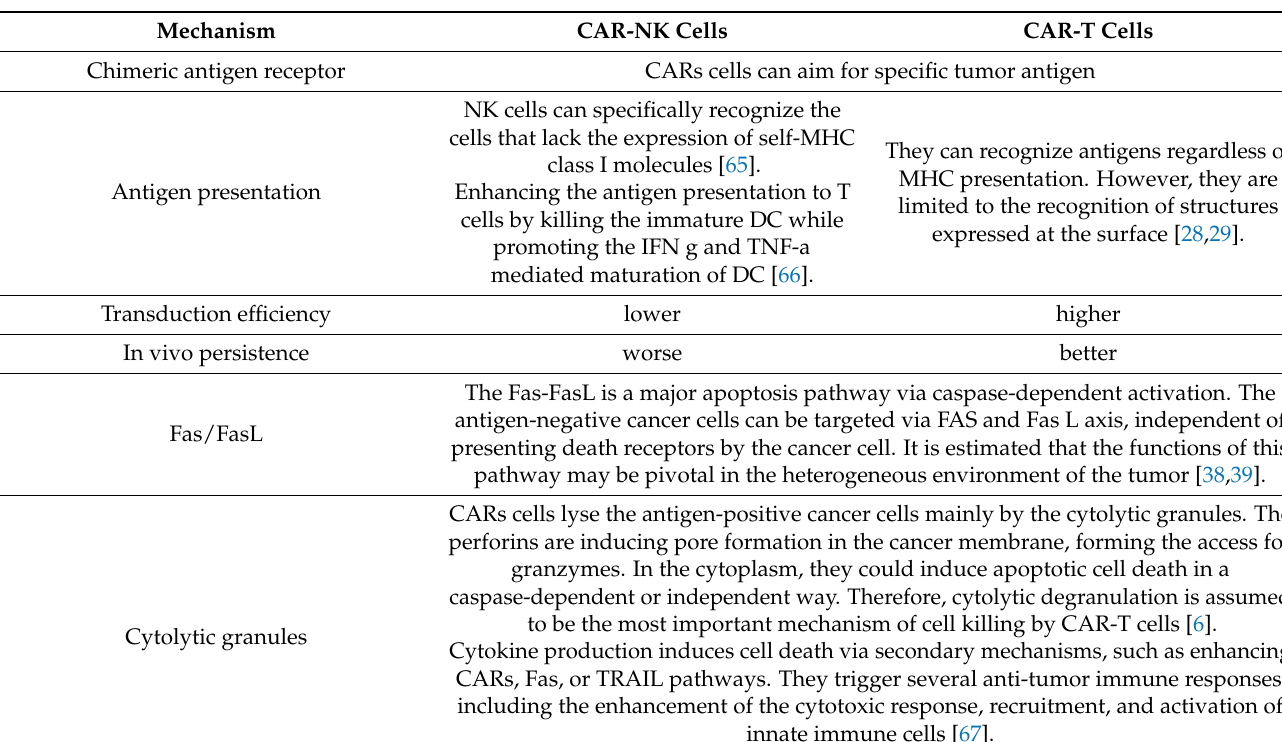
Table 3. Cytotoxic mechanism of CAR-NK and CAR-T